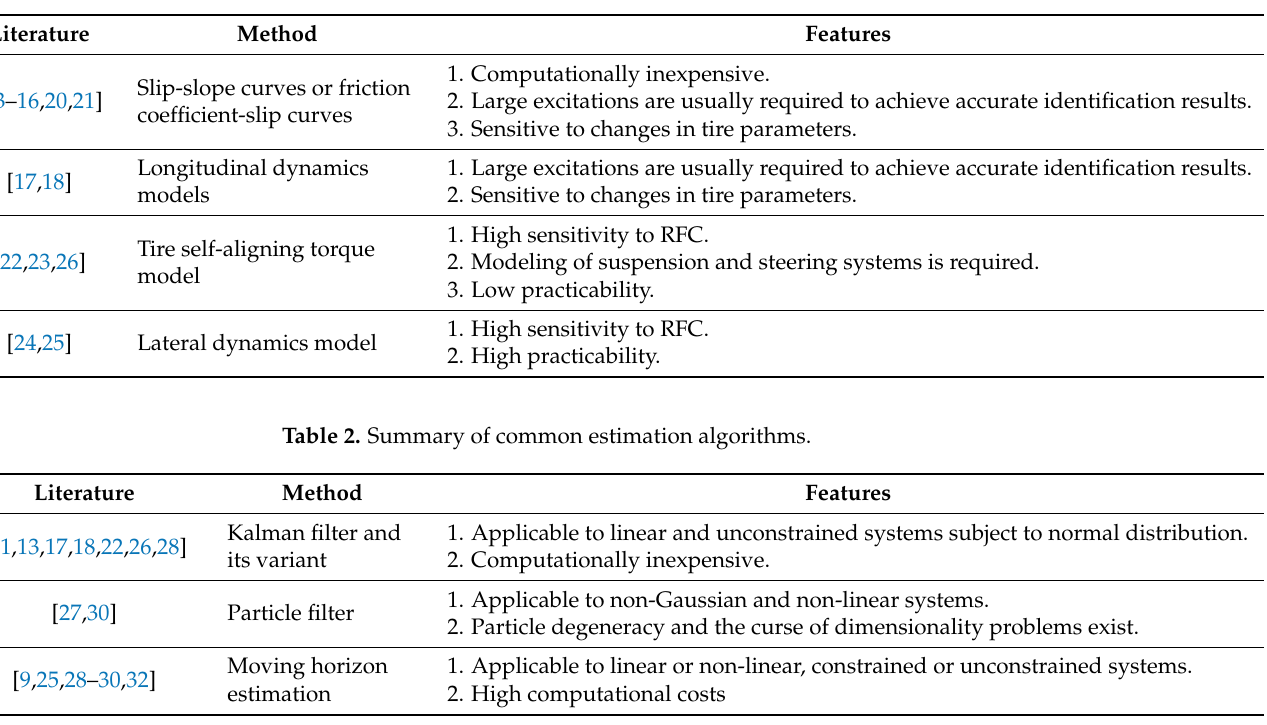
Table 1. Summary of different estimation methods based on vehicle dynamics.